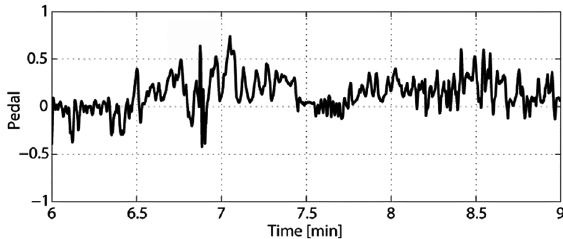
Fig. 13. Evolution of the output variable for longitudinal